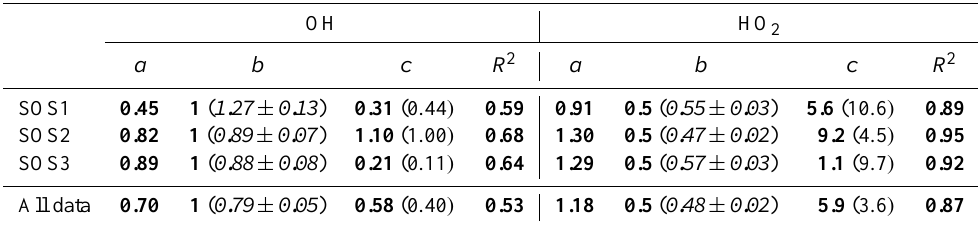
Table 4. Results of the analytical fits of Eq. (13) to the observed five-minute averaged [OH] and four-minute averaged [HO 2 ] using P (OH). The units of a are s (for b = 1) and molecule 1 / 2 cm − 3 / 2 s 1 / 2 (for b = 0 . 5), for OH and HO 2 , respectively. The units of c are 10 6 molecule cm − 3 . For ease of comparison, the values displayed in bold are those for forced fits of b = 1 and b = 0 . 5 for [OH] and [HO 2 ], respectively; the values in parentheses are the results of unforced fits together with the standard errors on b . The values of R 2 are virtually the same for the respective forced and unforced